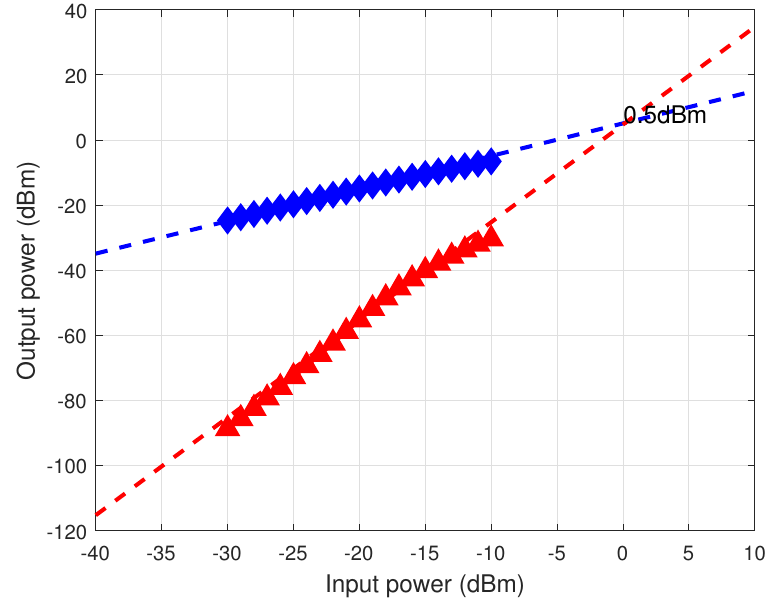
Figure 9. Input third-order intercept point (IIP 3 ). Table 2. Performance Comparison of Conventional versus Proposed Notch LNAs, [input power = − 50